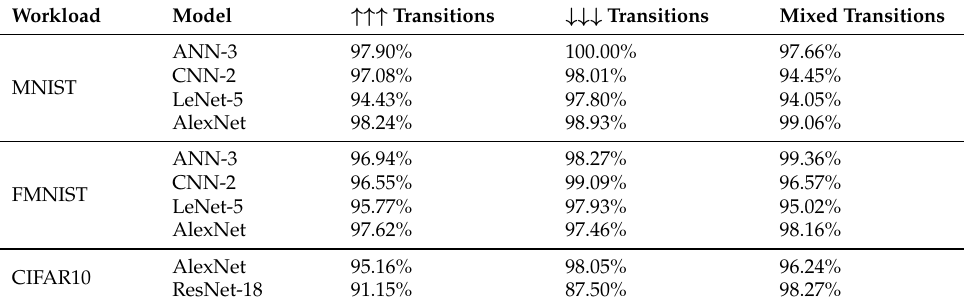
Table 6. Fault coverage in the presence of triple